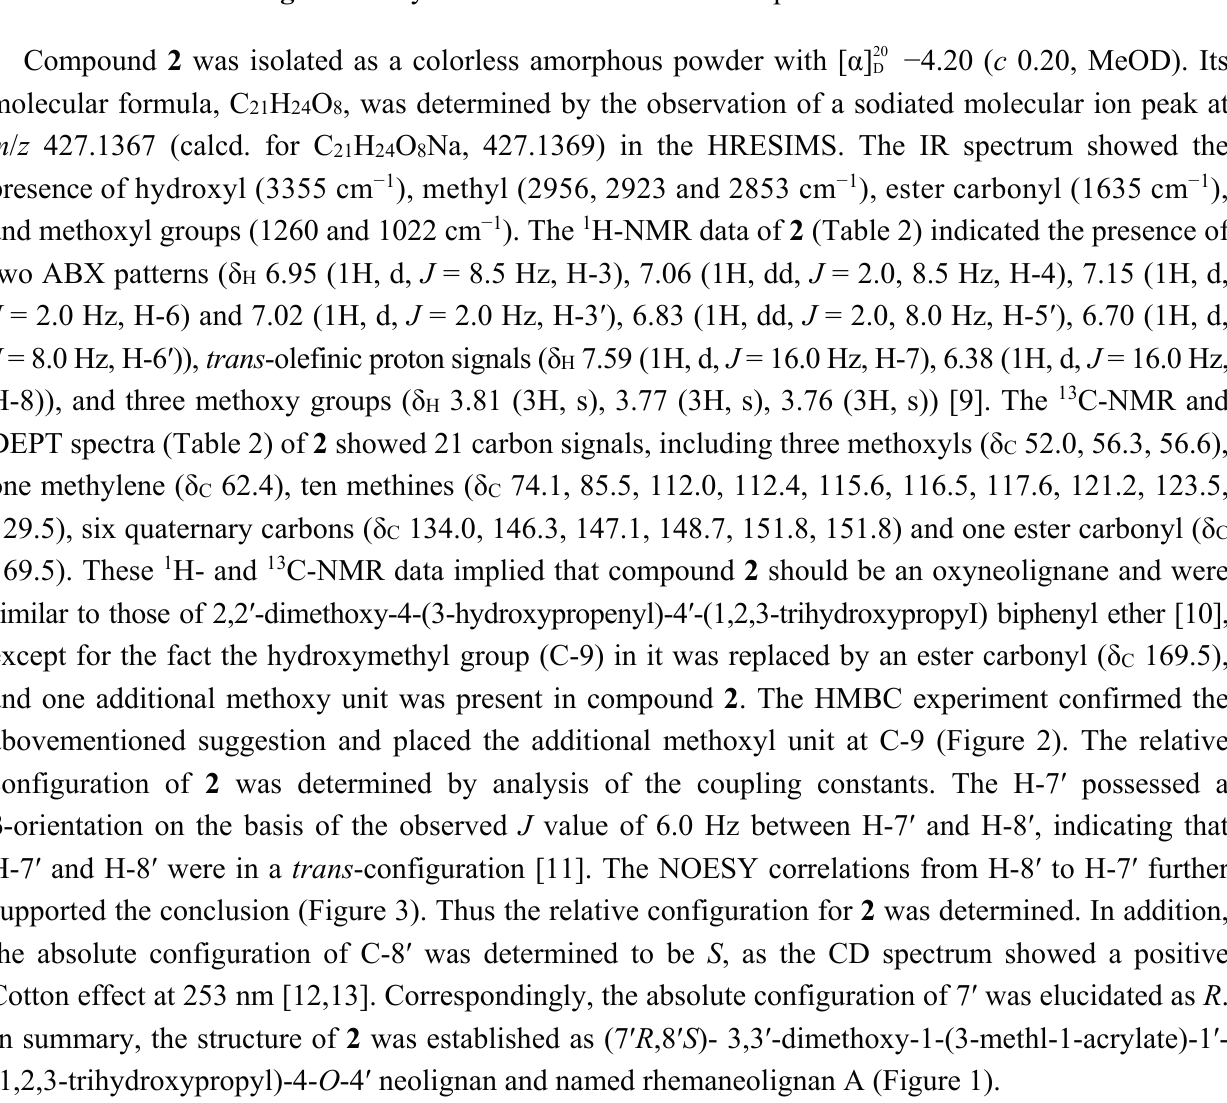
Figure 3. Key NOESY correlations of compounds 1 and 3